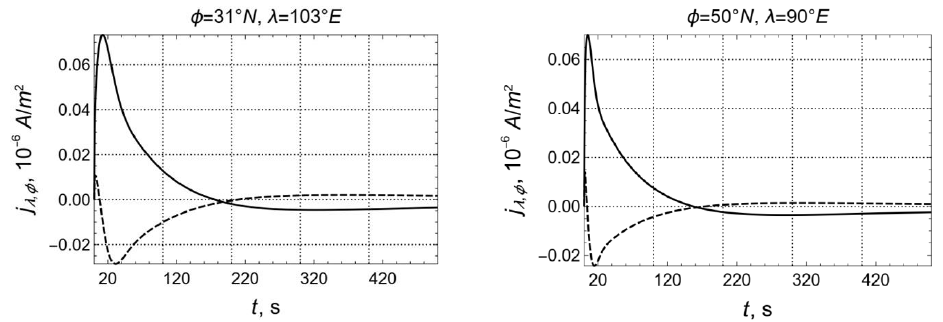
Figure 17. Time dependences of the electric current density components at different points. The zonal component ( j λ ) is a solid line, the meridional component ( j φ ) is a dotted line. The first point (31° N, 103° E) is close to the epicenter of the 12 May 2008 Sichuan earthquake (M w = 7.9; 31.021° N, 103.367° E).